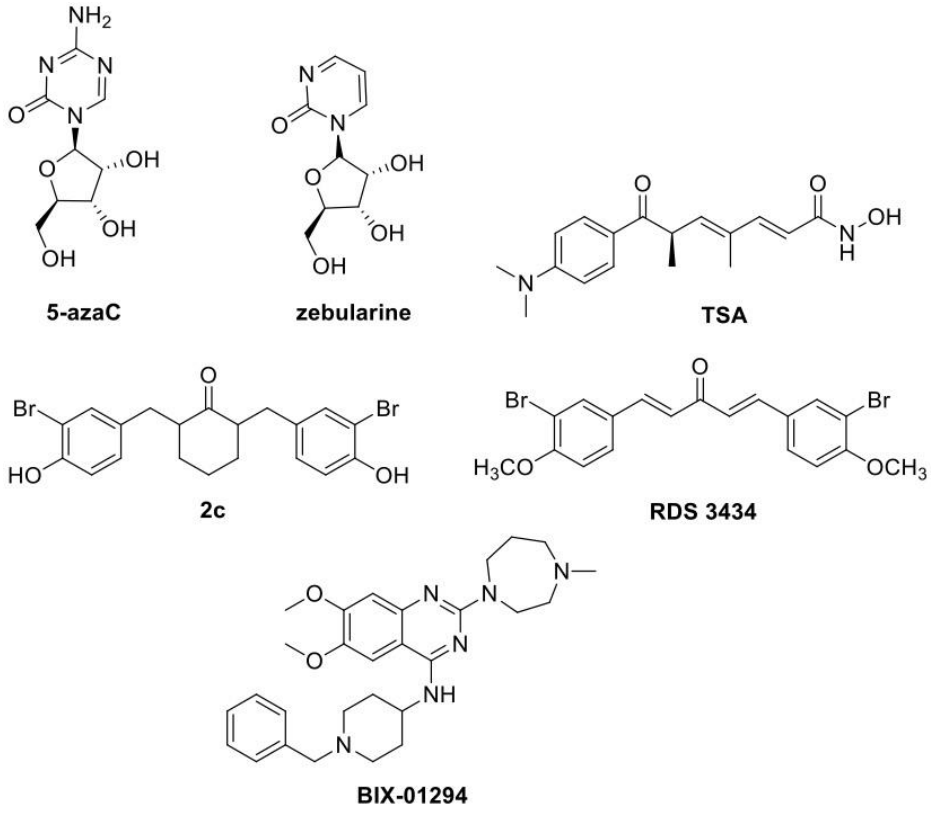
Figure 5. Chemical structures of small molecules involved in epigenetic processes. DNA methylation: 5-azaC [115], zebularine [125,126]. Histone Acetylation: TSA [128], 2c [141]. Histone methylation: RDS 3434 [144], BIX-01294 [145].